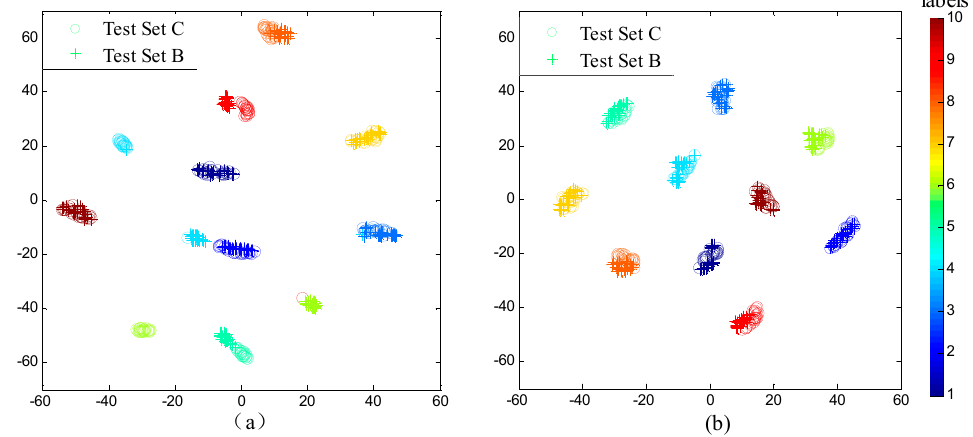
Figure 10. Feature visualization via t-SNE: last hidden fully-connected layer representation of WDCNN for ( a ) test set C and B before AdaBN, and ( b ) test C and B after AdaBN.